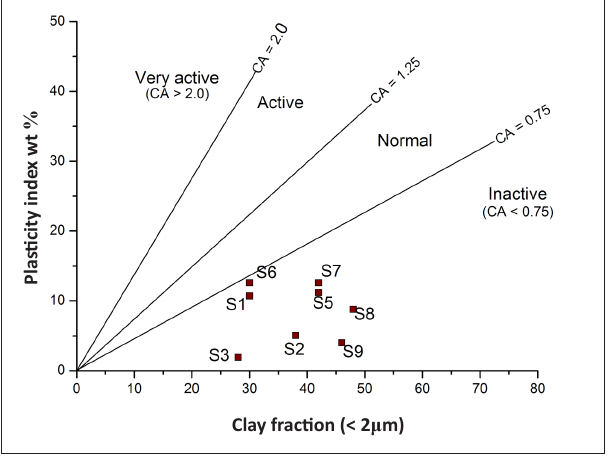
FIGURE 7: Soil plasticity with inferred clay mineralogy.